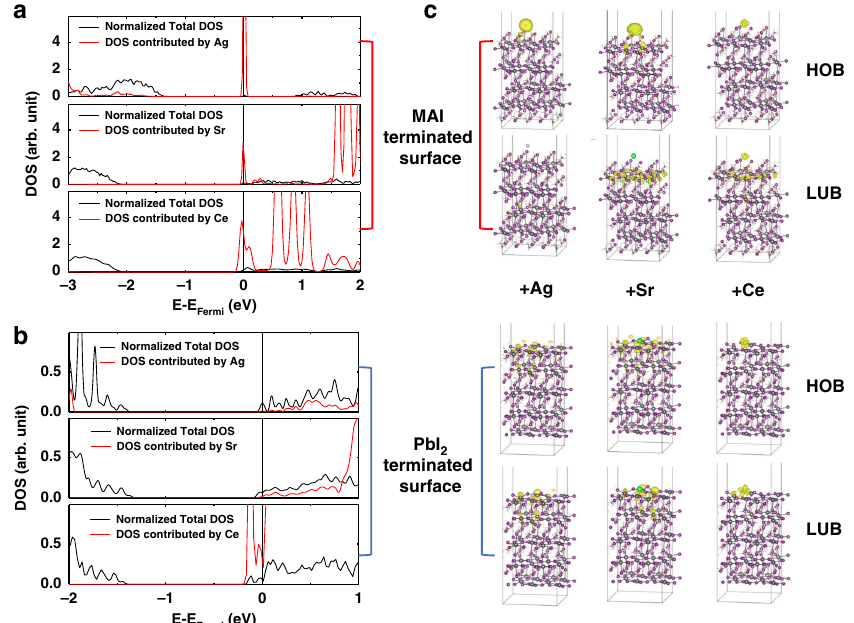
Fig. 4 Modeling of surface doping mechanism. Computed normalized total and partial DOS of Ag, Sr, and Ce adsorbed on a MAI-terminated and b PbI 2 - terminated surfaces of MAPbI 3 . c The iso-surface plot of the charge density of the highest occupied band (HOB) and the lowest unoccupied band (LUB) of Ag, Sr, and Ce adsorbed on MAI-terminated and PbI 2 -terminated surfaces of MAPbI 3 . The purple, grey, silver, green and chartreuse spheres represent I, Pb, Ag, Sr and Ce atoms, respectively. The charge density distribution is highlighted in